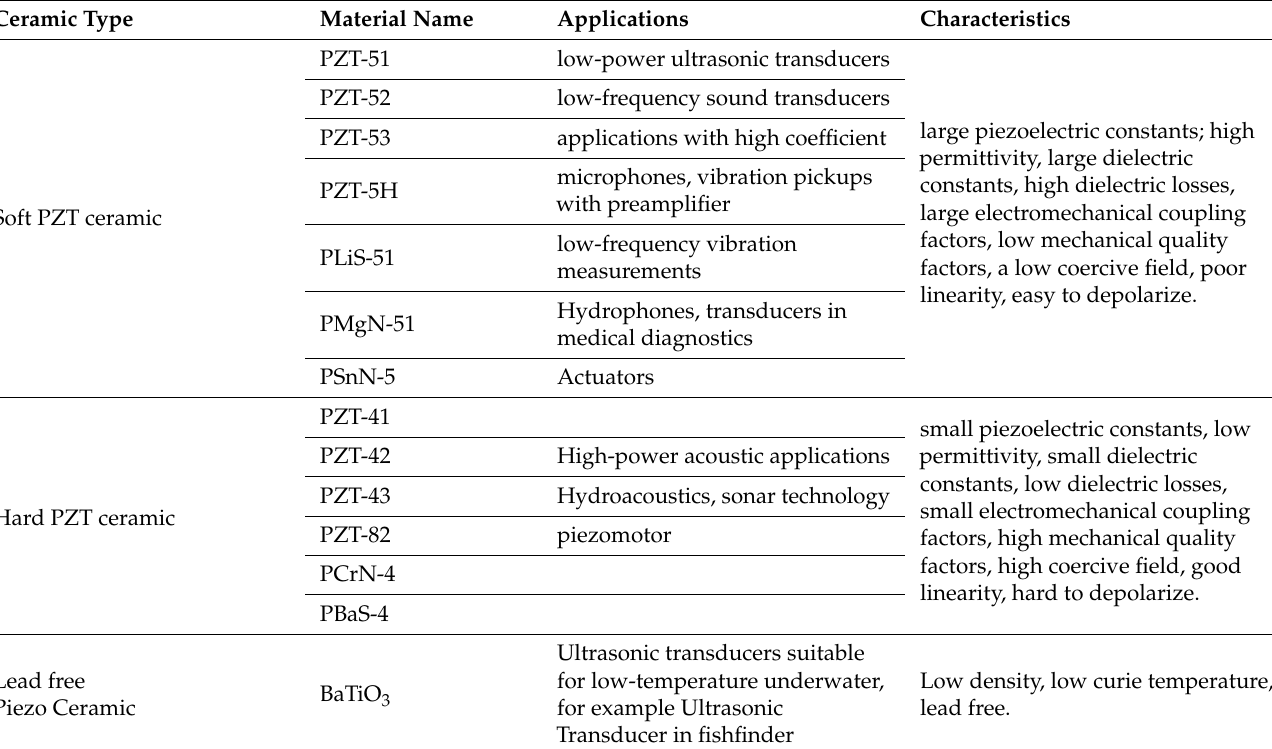
Table 1. Types, applications and characteristics of different piezoelectric